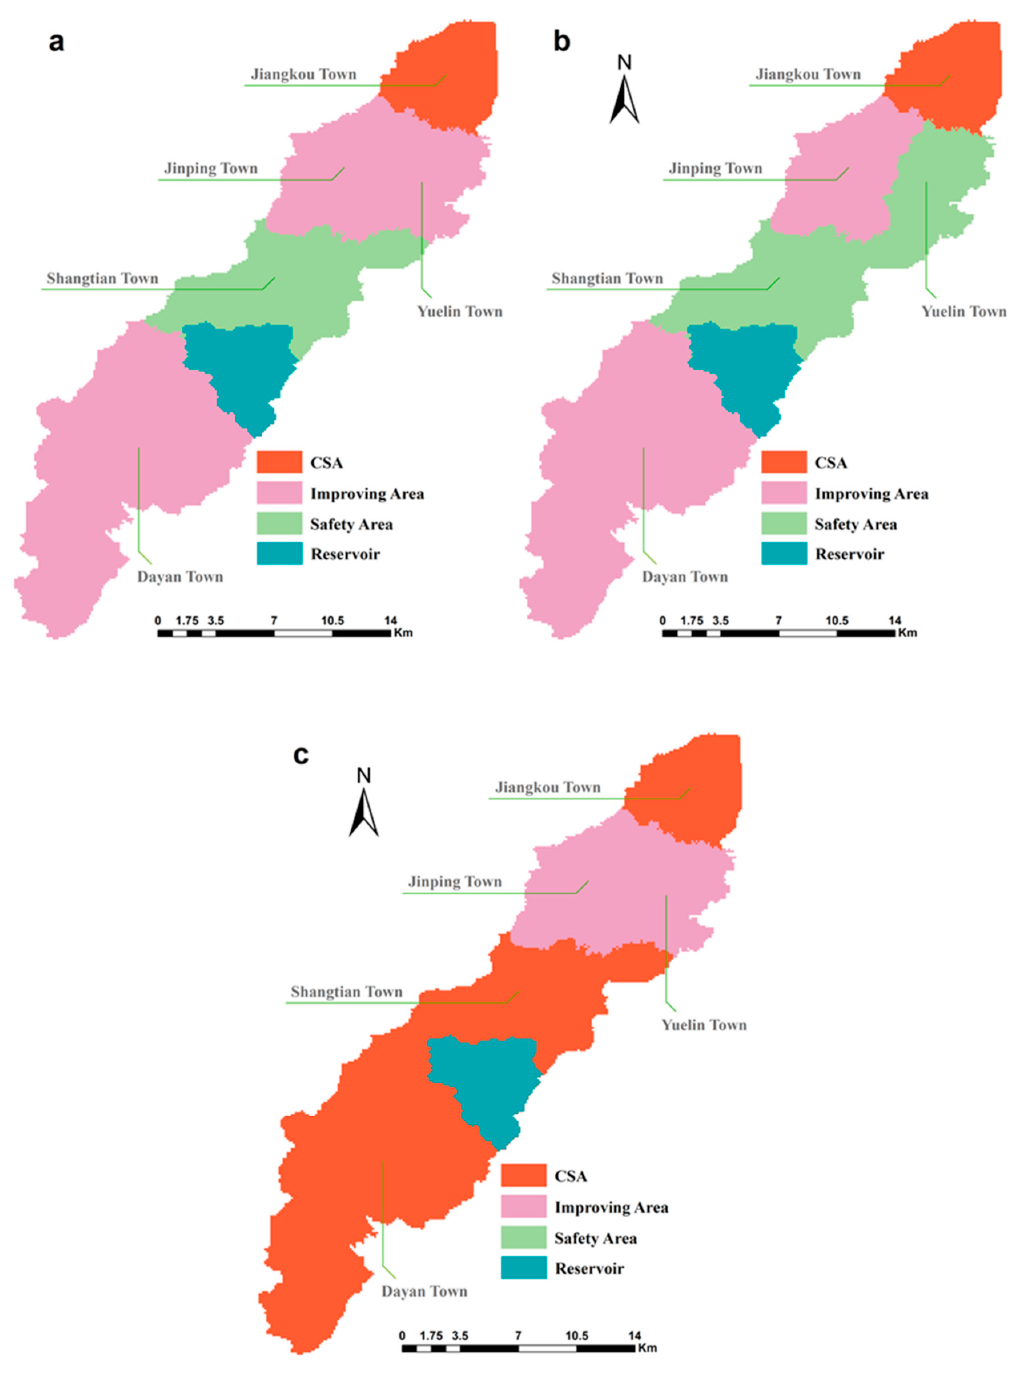
Figure 8. The spatial pattern of WLA unfair-factor districts: ( a ) COD; ( b ) NH 3 -N; ( c ) TP.